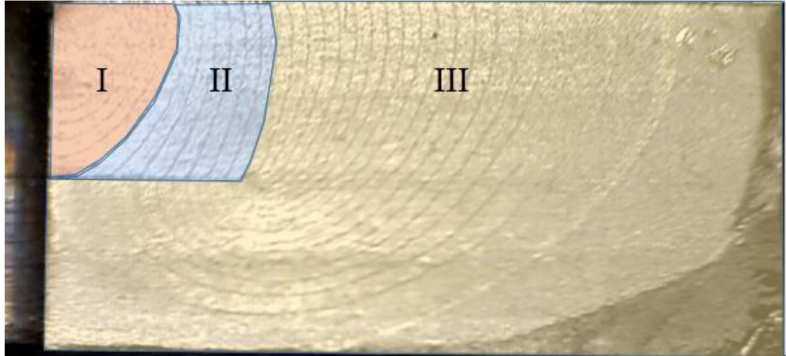
Figure 5. The three crack growth stages (I: The first stage, II: The second stage, III: The third